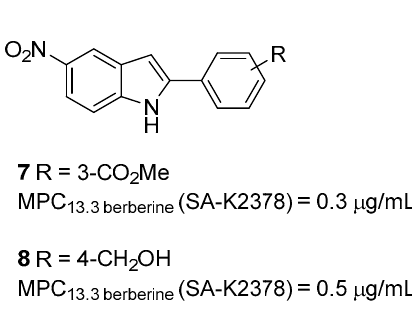
Figure 3. Indoles derivatives as NorA EPIs.